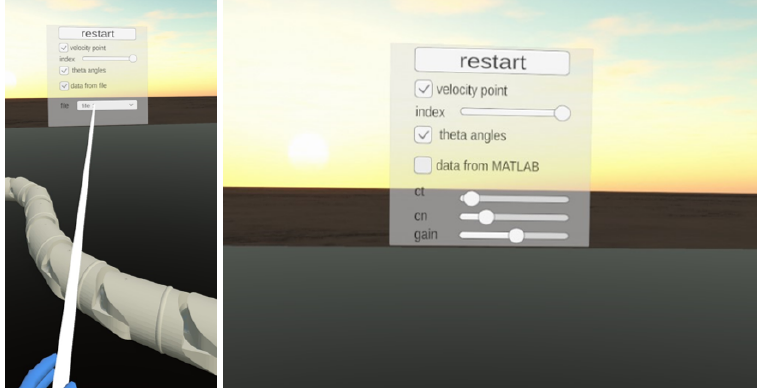
Figure 6. Graphical User Interface and controllers ray allowing interaction with